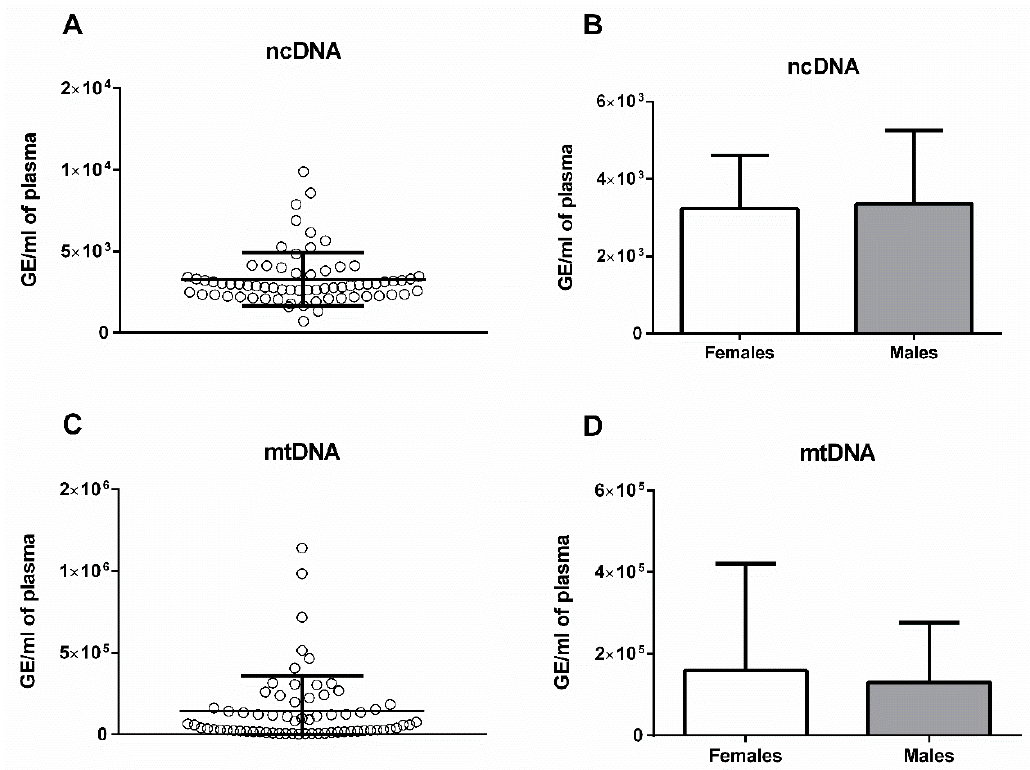
Figure 2. ( a ) Nuclear extracellular DNA (ncDNA; n = 57) and ( b ) nuclear extracellular DNA divided by sex (females n = 34, males n = 23; t -test; p = 0.26, t = 1.14) and ( c ) mitochondrial extracellular DNA (mtDNA; n = 57), and ( d ) mitochondrial extracellular DNA divided by sex (females n = 34, males n = 23; t -test; p = 0.41, t = 0.83). The extracellular DNA of both a nuclear and mitochondrial origin is expressed in genome equivalents (GE) per ml of plasma. The results are presented as mean + standard deviation. Table 2. Correlation matrix describing the relationships between the analyzed variables, namely: bodyweight, age, total extracellular DNA (ecDNA), nuclear ecDNA (ncDNA), mitochondrial ecDNA (mtDNA), and deoxyribonuclease (DNase) activity. The data in the table are presented as Pearson’s correlation coe ffi cients with p -values indicated as p < 0.001 for